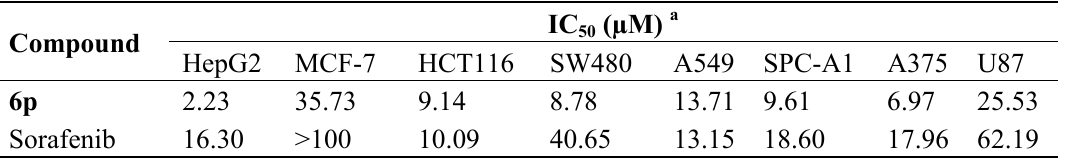
Table 2. Inhibition of cell proliferation by compound 6p and Sorafenib.